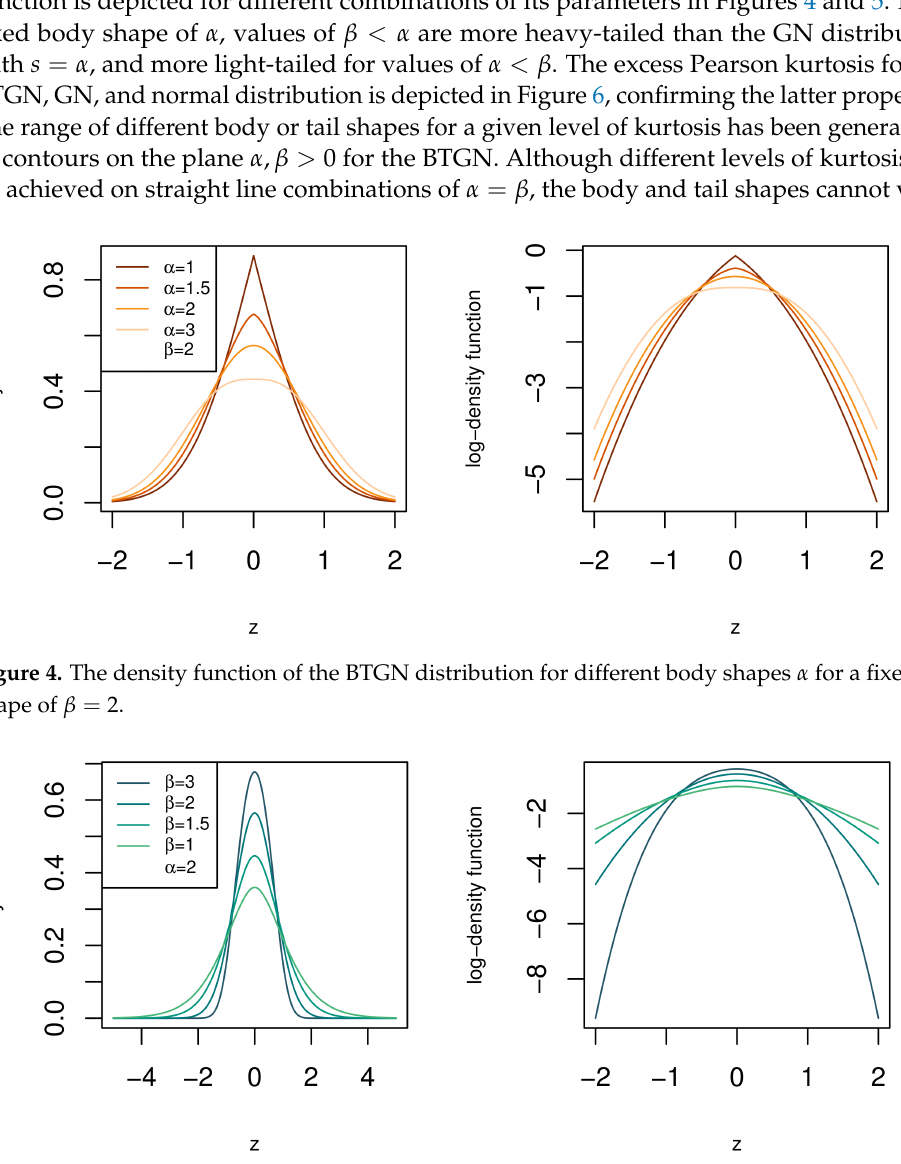
Figure 5. The density function of the standard BTGN for different tail shapes of β for a fixed body shape of α =